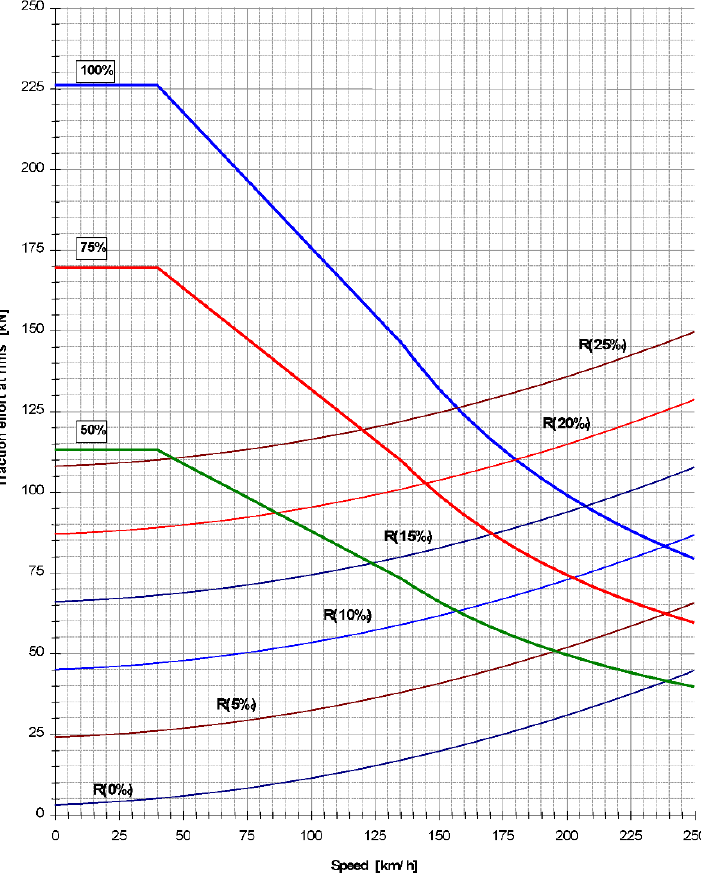
Figure 4. Traction effort [kN] and resistance R[kN] as a function of ETR 610 (ED250) train speed at 100%, 75%, and 50% power available. Source: Alstom.